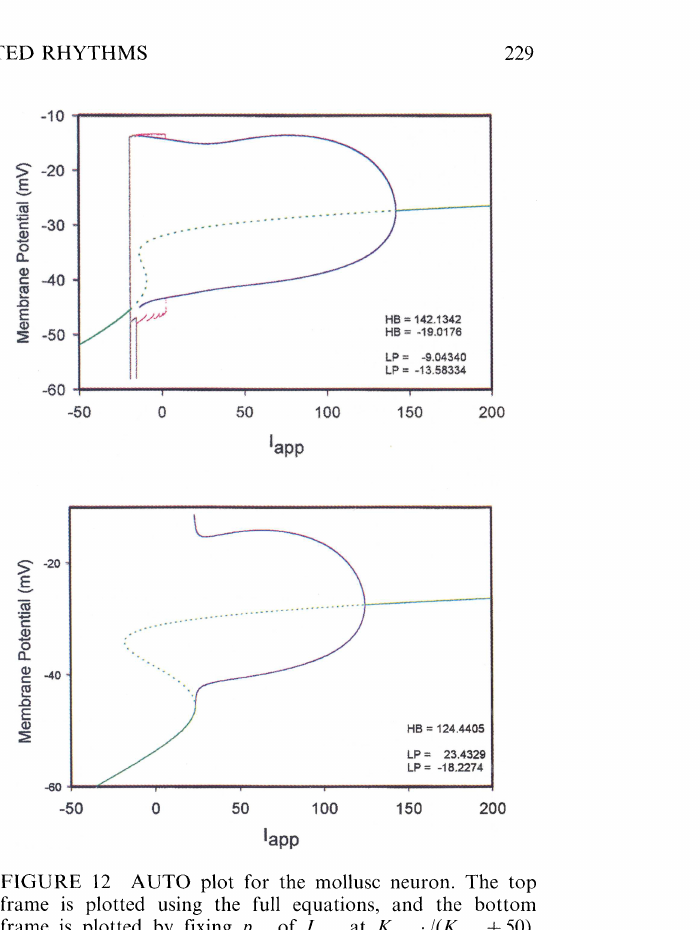
FIGURE 12 AUTO plot for the mollusc neuron. The top frame is plotted using the full equations, and the bottom frame is plotted by fixing Po of Icr,c at Kcr,c"/(Kcr,c + 50). (See Color Plate